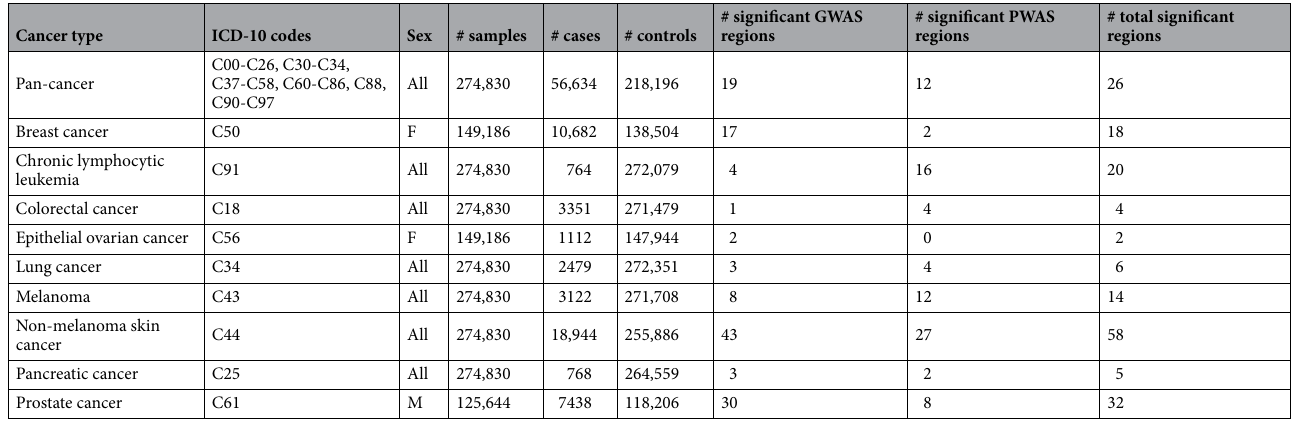
Table 2. Studied cancer